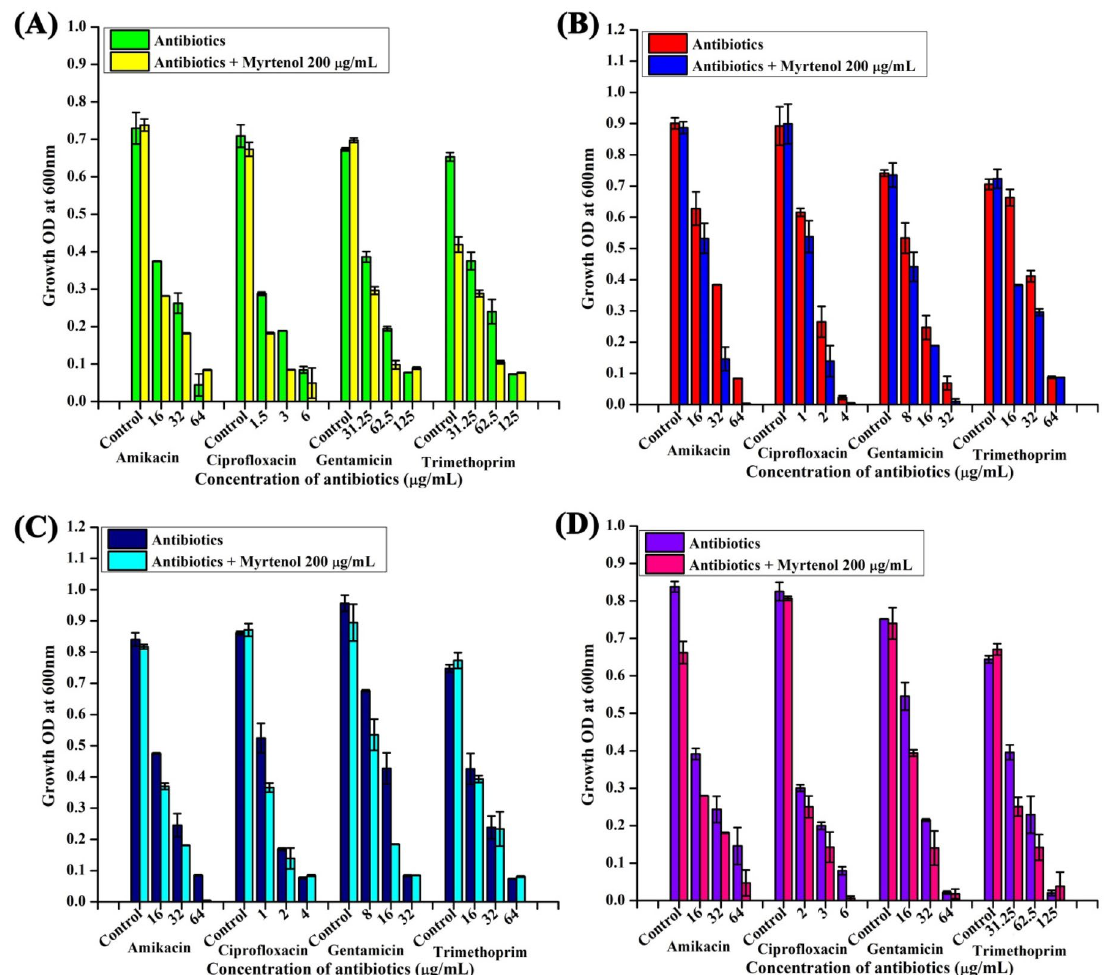
Figure 9. Effect of myrtenol (200 μg/mL) on the susceptibility of AB-ATCC 19606, AB-MTCC 9826, AB-A10-3 and AB-A42-4 to antibiotics. Error bars and asterisks indicate the SD and statistical significance ( p < 0.05), respectively.